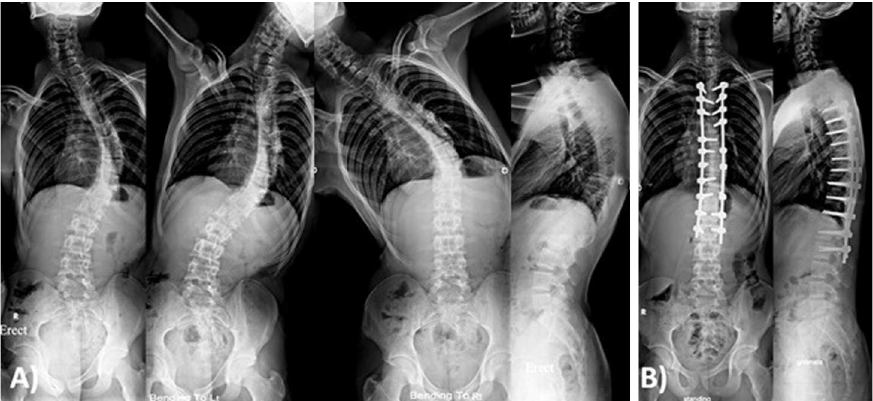
Figure 1. Male patient 17 years old with Lenke 1a n. (A) Preoperative X-rays showing main thoracic curve of 50 ° that was corrected to 29 ° in side bending films with thoracic kyphosis of 40 ° . (B) One year postoperative X-rays showing posterior instrumentation from T4-L2 with main thoracic curve correction to 9 ° with thoracic kyphosis of 36 ° .